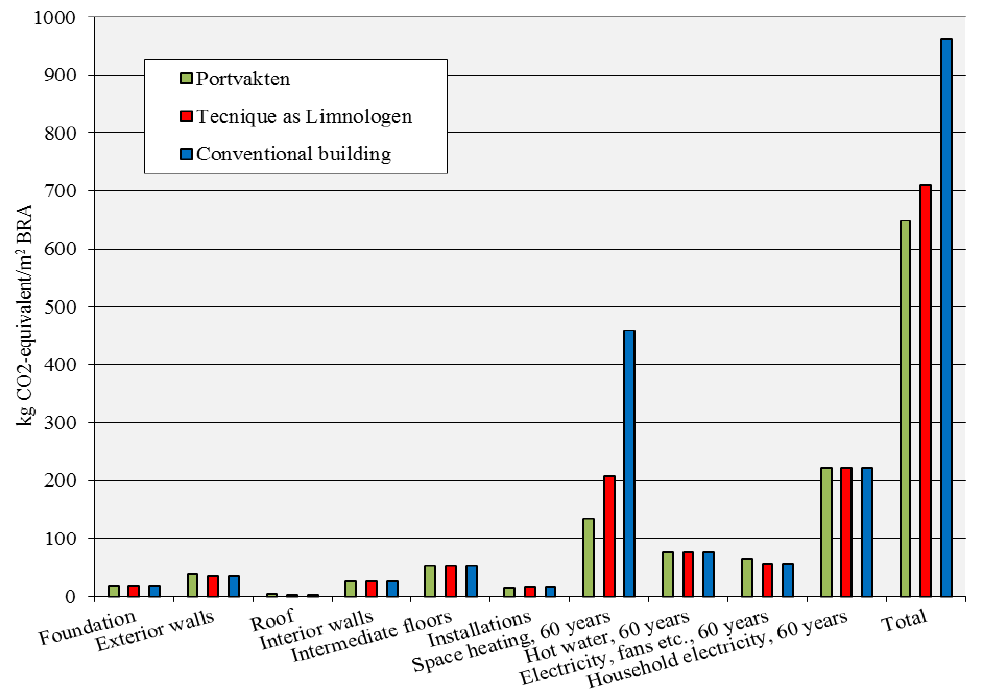
Figure 9. Potential contribution to global climate change, including 60 years of -eq/m 2 operation, kg CO 2